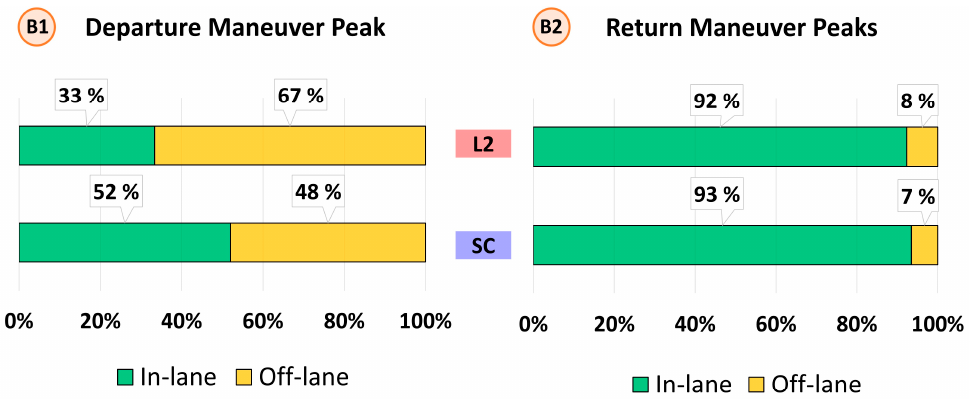
Figure 13. Event analysis of aborted overtaking (maneuver B).